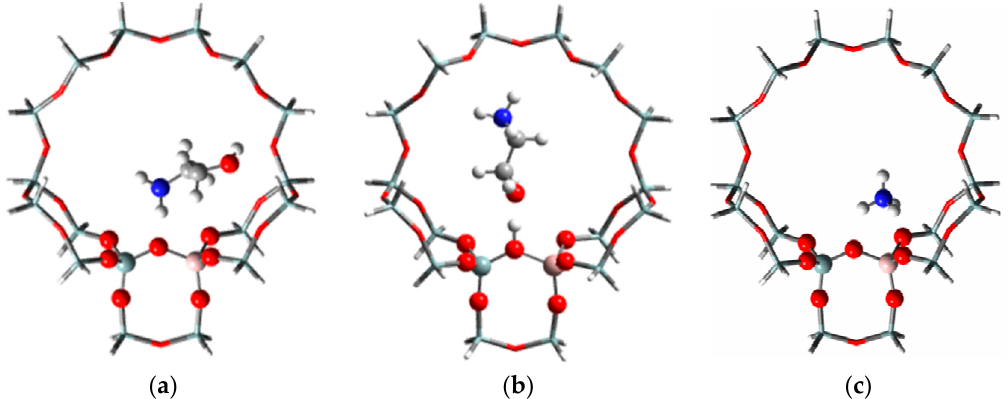
Figure 10. Adsorption model of NH 3 and different groups of MEA over H-MOR. ( a ) MEA – N – H